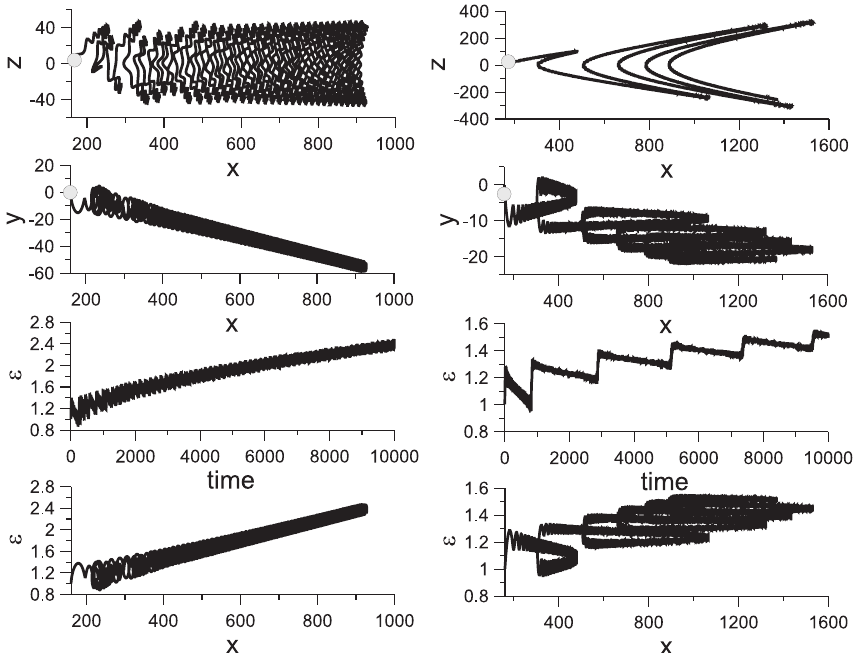
Fig. 5. Two trajectories of adiabatic particles with different initial pitch-angles. Left panels corresponds to large pitch-angle, while right panels show results for small pitch-angle. Also evolutions of the particle energies, ε , with time and as a function of x-coordinate are presented.